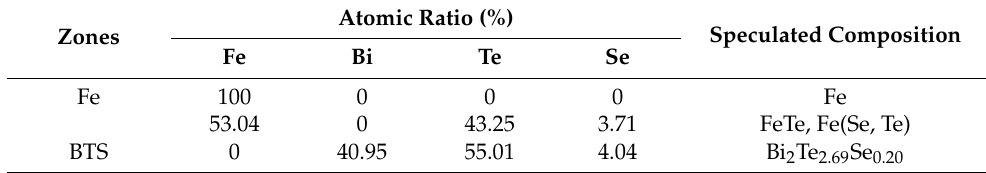
Table 2. EDS results and speculated compositions of the different zones in Figure 5.